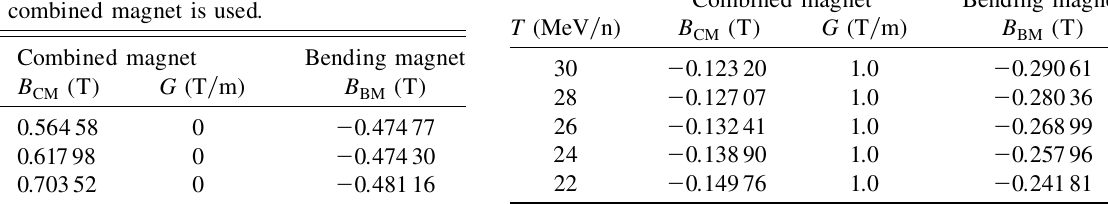
(cid:3) ion beams. 2 (cid:3) ion 2